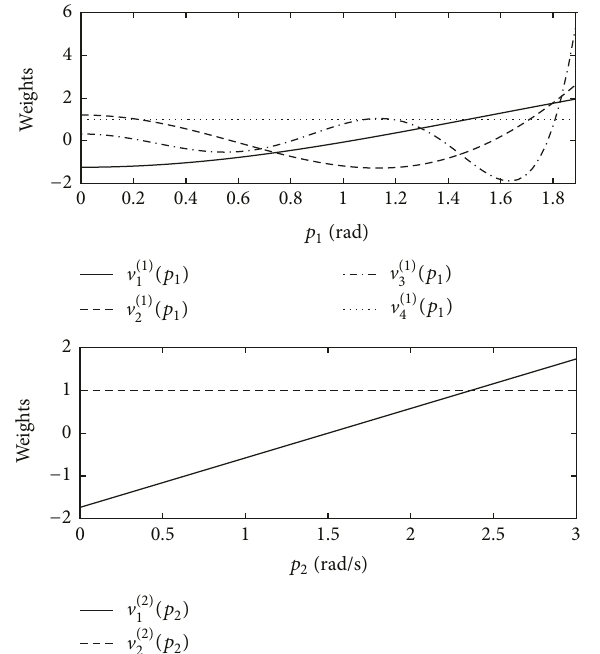
Figure 2: The k (1) (𝑝 1 ) and k (2) (𝑝 2 ) weighting functions in the Affine TP Model.